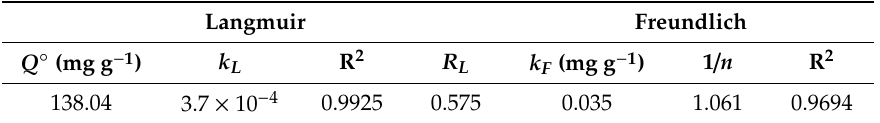
Table 3. Langmuir’s and Freundlich’s isotherm parameters at 20 ◦ C, C 0 = 0.5 g L − 1 , and pH = 3.8. Langmuir Freundlich